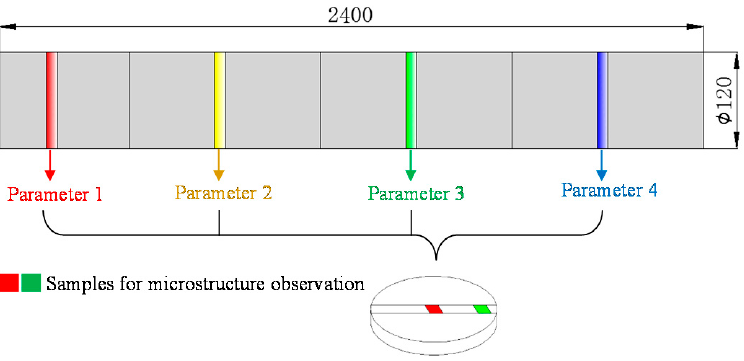
Figure 2. Schematic illustration of discs and samples for microstructural observation. Color lines: the discs location in the billet.